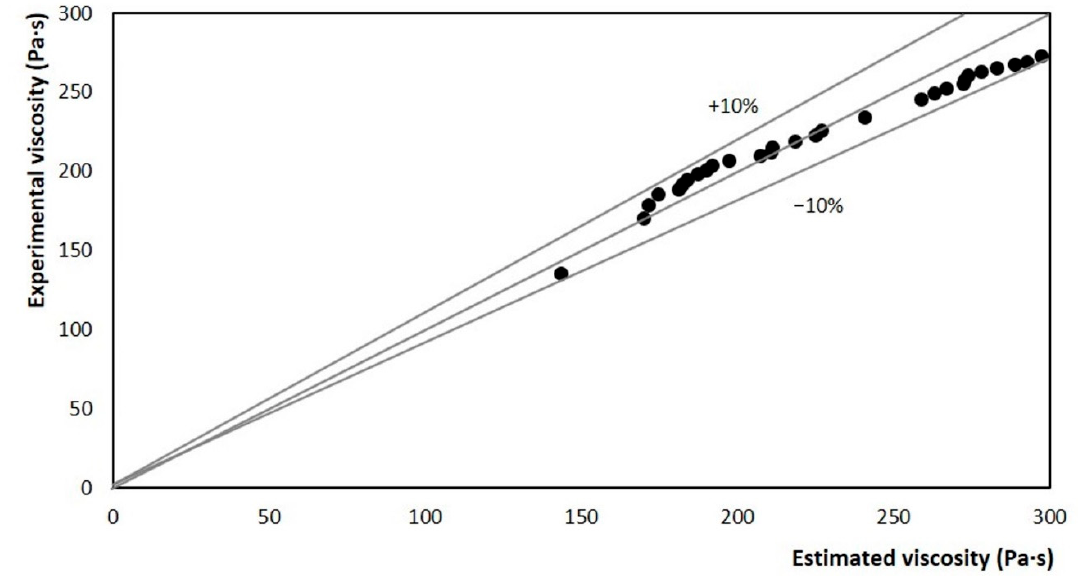
Figure 12. Comparison between experimental and estimated values for apparent viscosity, using the model as a function of the stirring motor power at 3.33 rev/s.